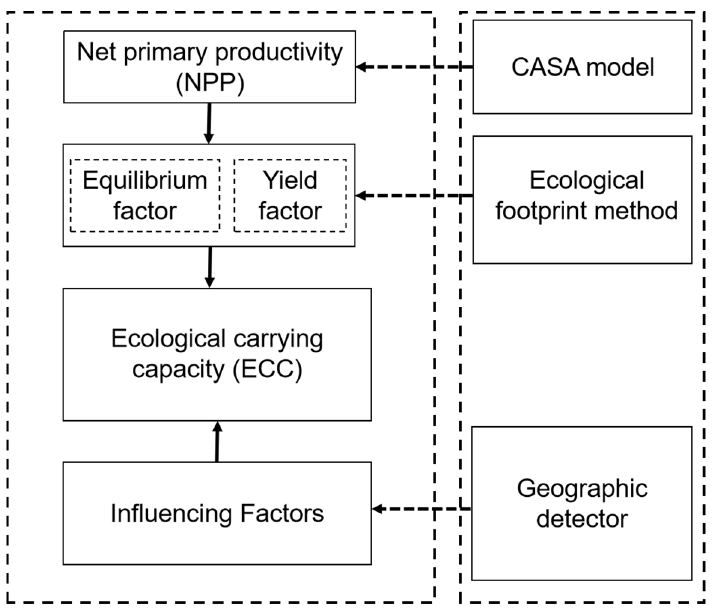
Figure 2. Technical route of this research.